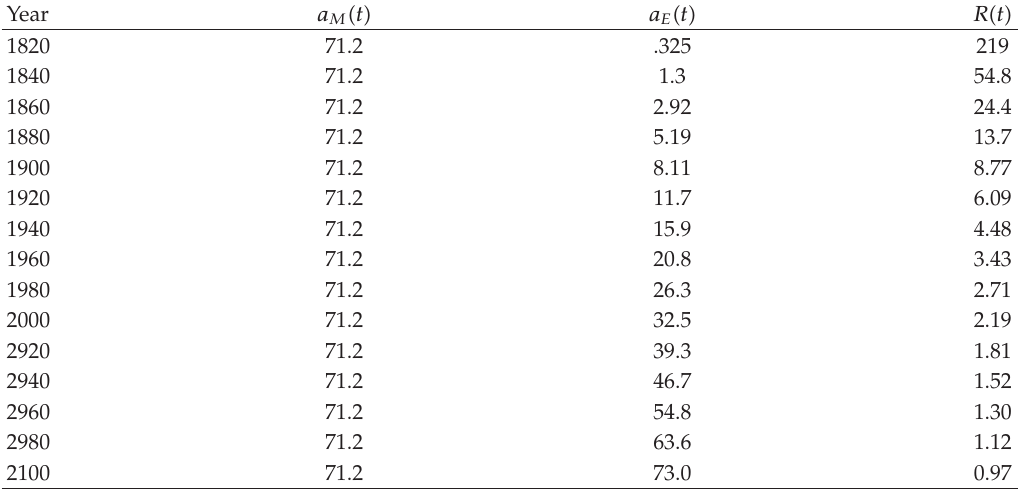
Table 2: Temporal change in the importance of the military and economic capabilities to national power.